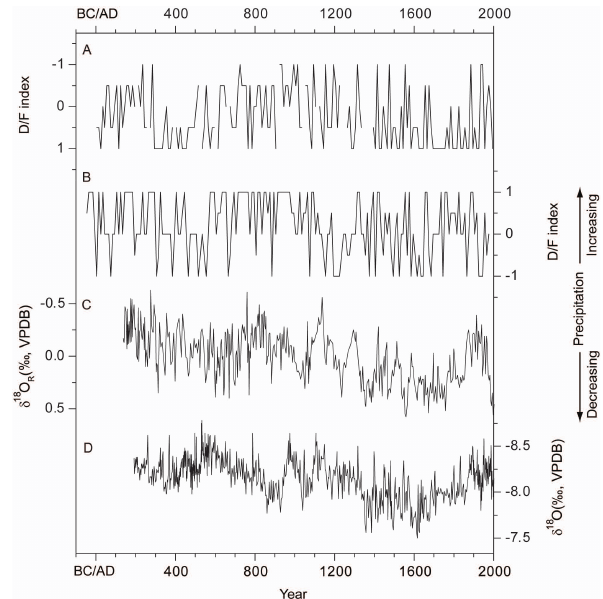
Fig. 1. Map showing the location of north central China and the palaeoclimate sites mentioned in this study. (A) Haihe River Basin (Yan et al., 1993), (B) Longxi (Tan et al., 2008, 2010), (C) Huangye cave (Tan et al., 2011), (D) Wanxiang cave (Zhang et al., 2008), (E) Dulan (Liu et al., 2009), (F) Gonghai Lake (Liu et al., 2011). The elliptic area generally indicates north central China. The small insert image in the top left corner shows the annual precipitation of China.